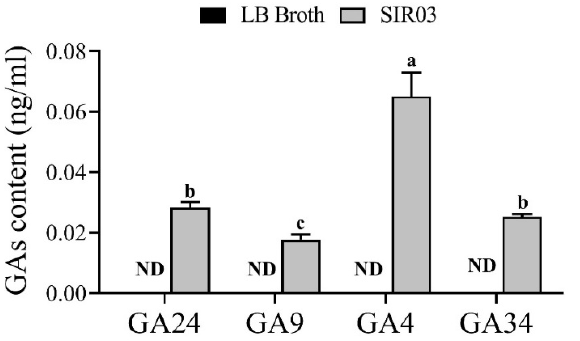
Figure 1. Effects of isolate SIR03 on the growth of Waito-C rice (GA deficient).